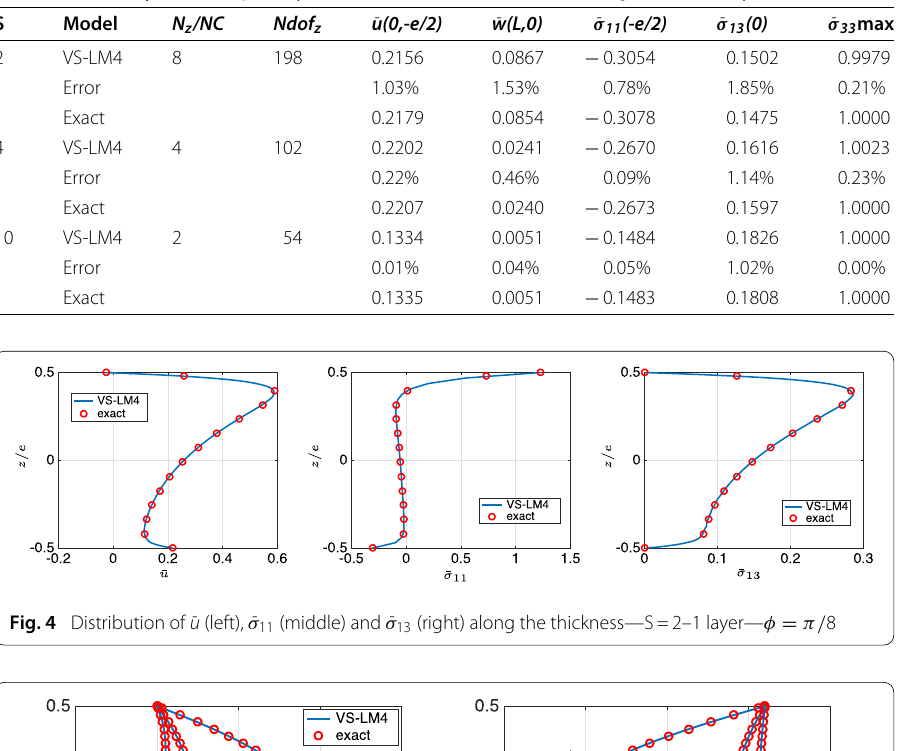
Table6 One layer [0 ◦ ] — φ = π/ 8 —mesh 26 × 10—two-order expansion of 1 /μ